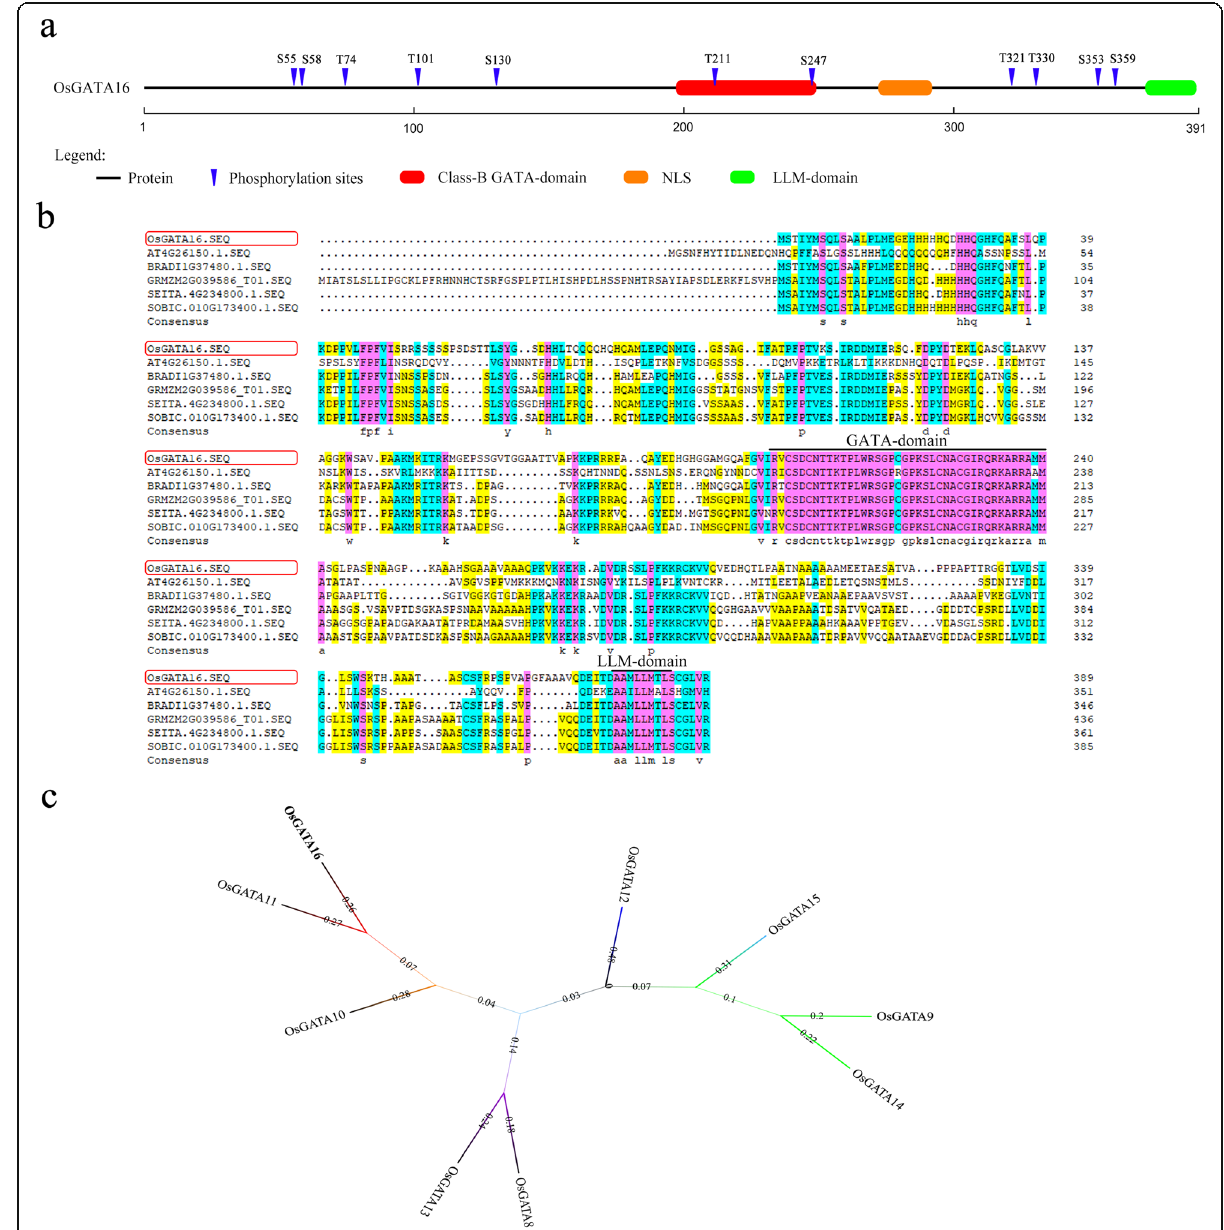
Fig. 1 Bioinformatic analysis of OsGATA16 protein. a Structure of OsGATA16 protein. Numbers correspond to locations within the full-length protein. b Comparison of OsGATA16 homologous genes in various species. Black lines represent diverse domain, pink represents identical amino acid residues, and similar amino acid residues are highlighted in blue and yellow. c Phylogenetic tree of OsGATA subfamily-II proteins. Numbers represent level of